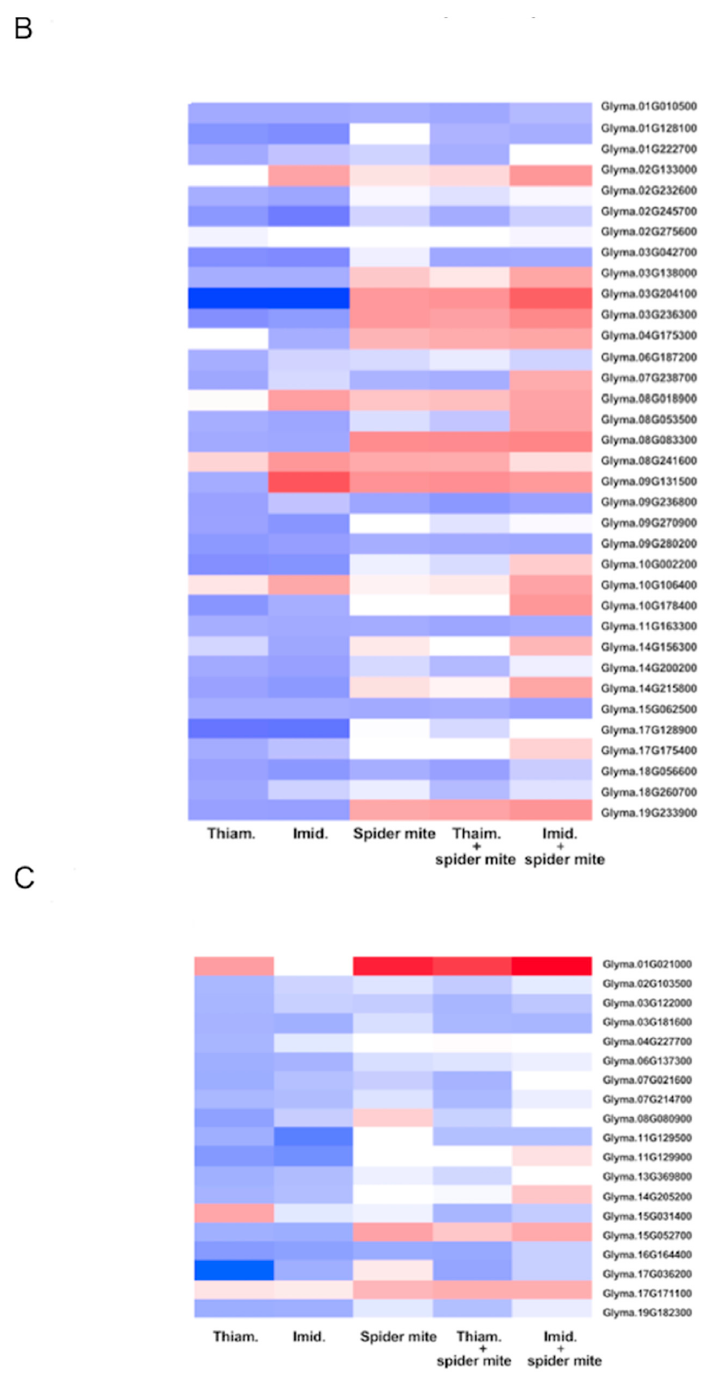
Figure 5. Heat map of DEGs involved in cell wall biosynthesis and metabolism ( A ), plant–pathogen interactions pathway ( B ), and phenylpropanoid biosynthesis pathway ( C ) in soybean exposed to thiamethoxam, imidacloprid, spider mites, and the combination of either neonicotinoid insecticide and spider mites. The color key represents log2-transformed fold change; red bars indicate induction of expression, while blue bars represent a decrease in expression. Expression of genes involved in the phenylpropanoid pathway was also affected by the neonicotinoids and spider mites (Supplementary File 5). The phenylpropanoid pathway is a rich